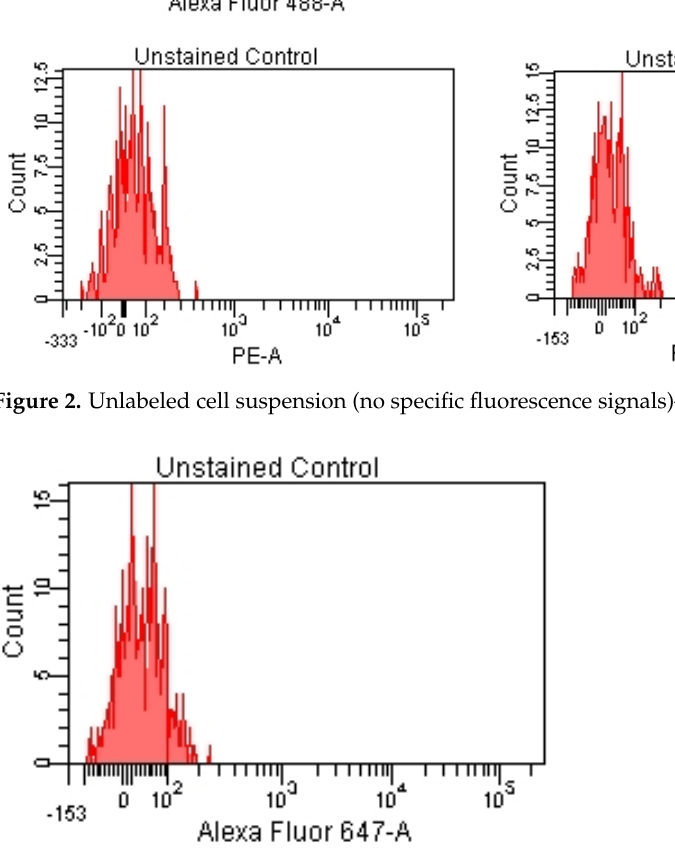
Figure 3. Unlabeled cell suspension (no specific fluorescence signals)—red laser stimulation.